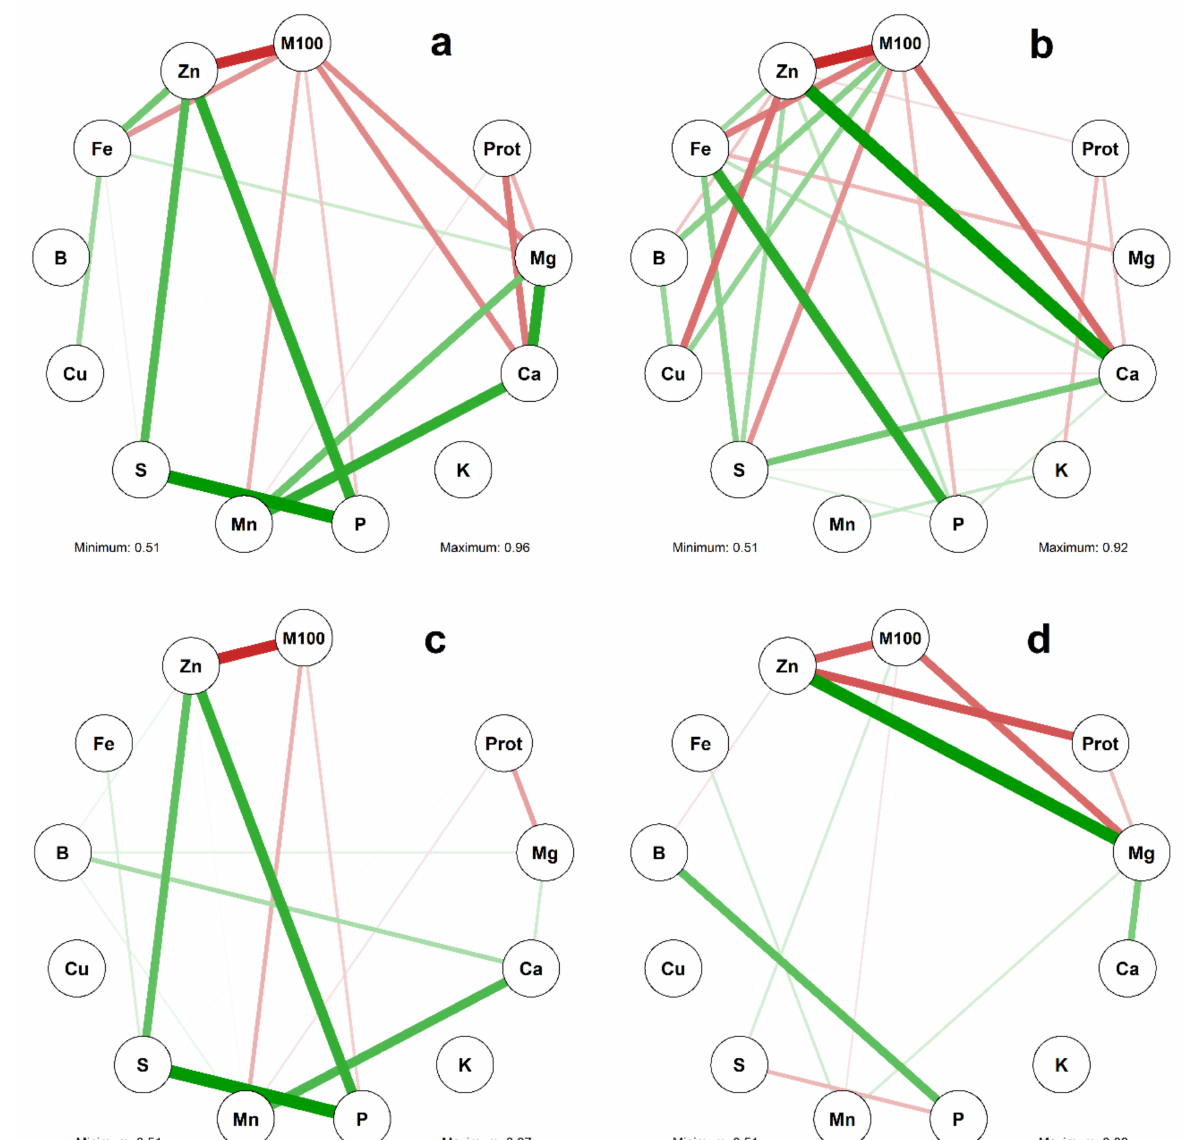
Figure 1. Networks of correlations between the characteristics of 100-grain mass (M100), protein content (Prot), and contents of 10 mineral in the whole grains ( a ), seed coat ( b ), cotyledons ( c ), and embryonic axis ( d ) of 10 bean ( Phaseolus vulgaris L.) cultivars derived from different centers of origin. The green and red lines represent estimates of the positive and negative simple Pearson linear correlations ( p ≤ 0.05), respectively. The thickness of the lines is proportional to the magnitude of the